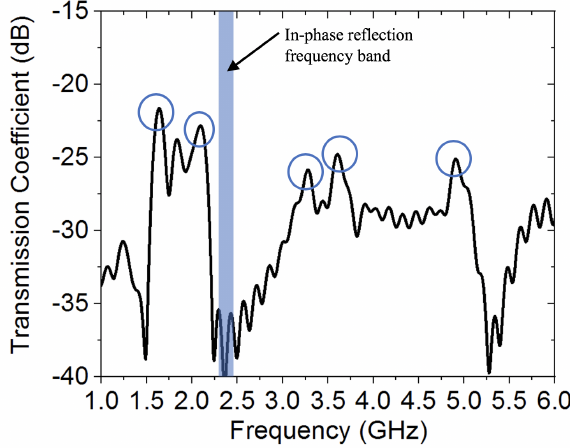
Figure 20. Computed transmission coefficient between the two cotton fabric layers of the HIS structure to estimate embedded parallel-plate waveguide